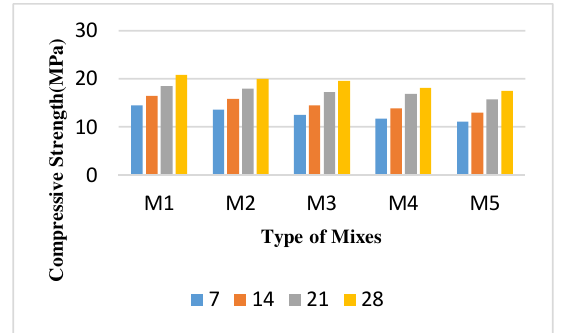
Fig. 6: Compressive Strength of Concrete by substituting the normal crush with various proportions of recycled aggregates